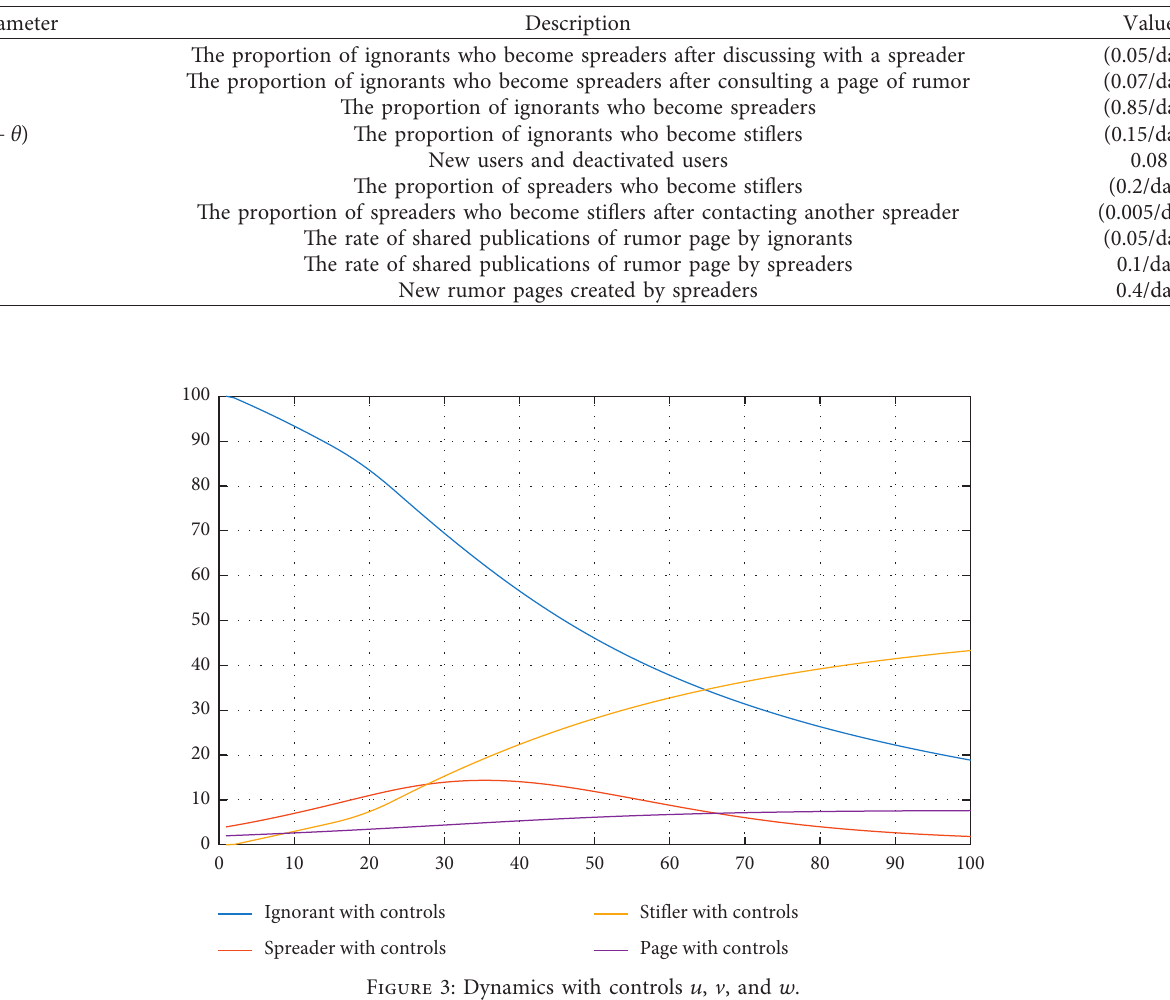
Table 1: Rumor model parameters and values.